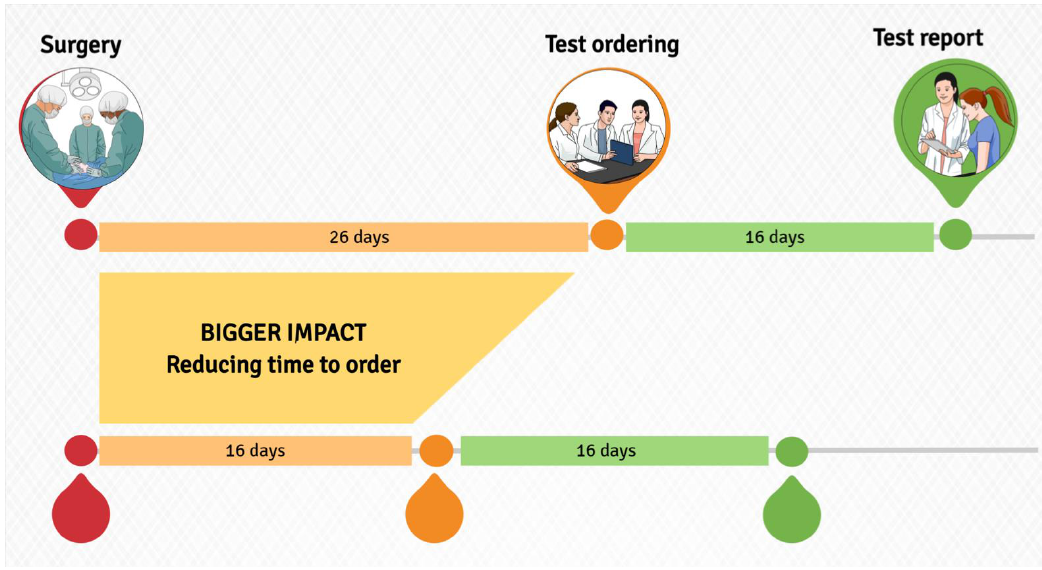
Figure 1. Expected benefit by improving workflow and streamline processes.